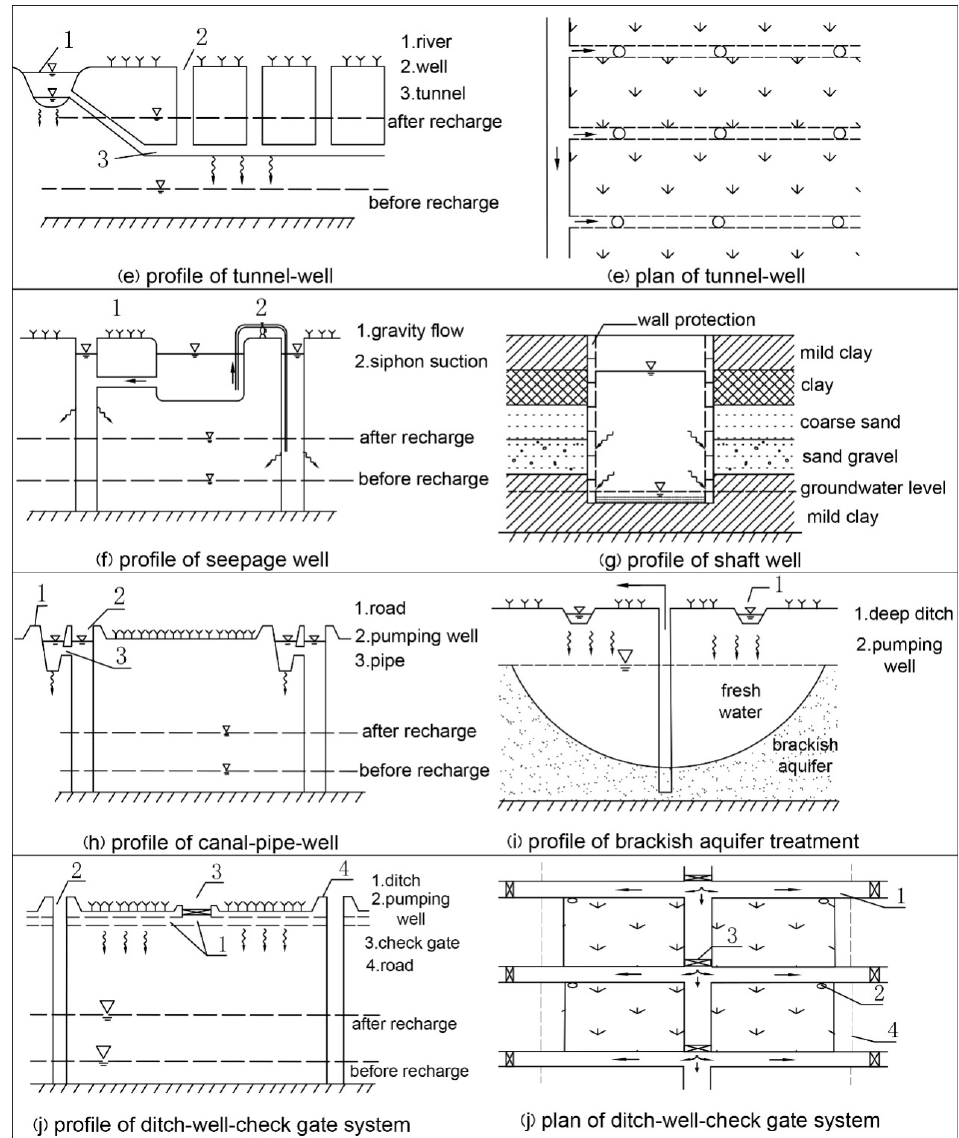
Figure 1. Specific types of MAR in agricultural irrigation.